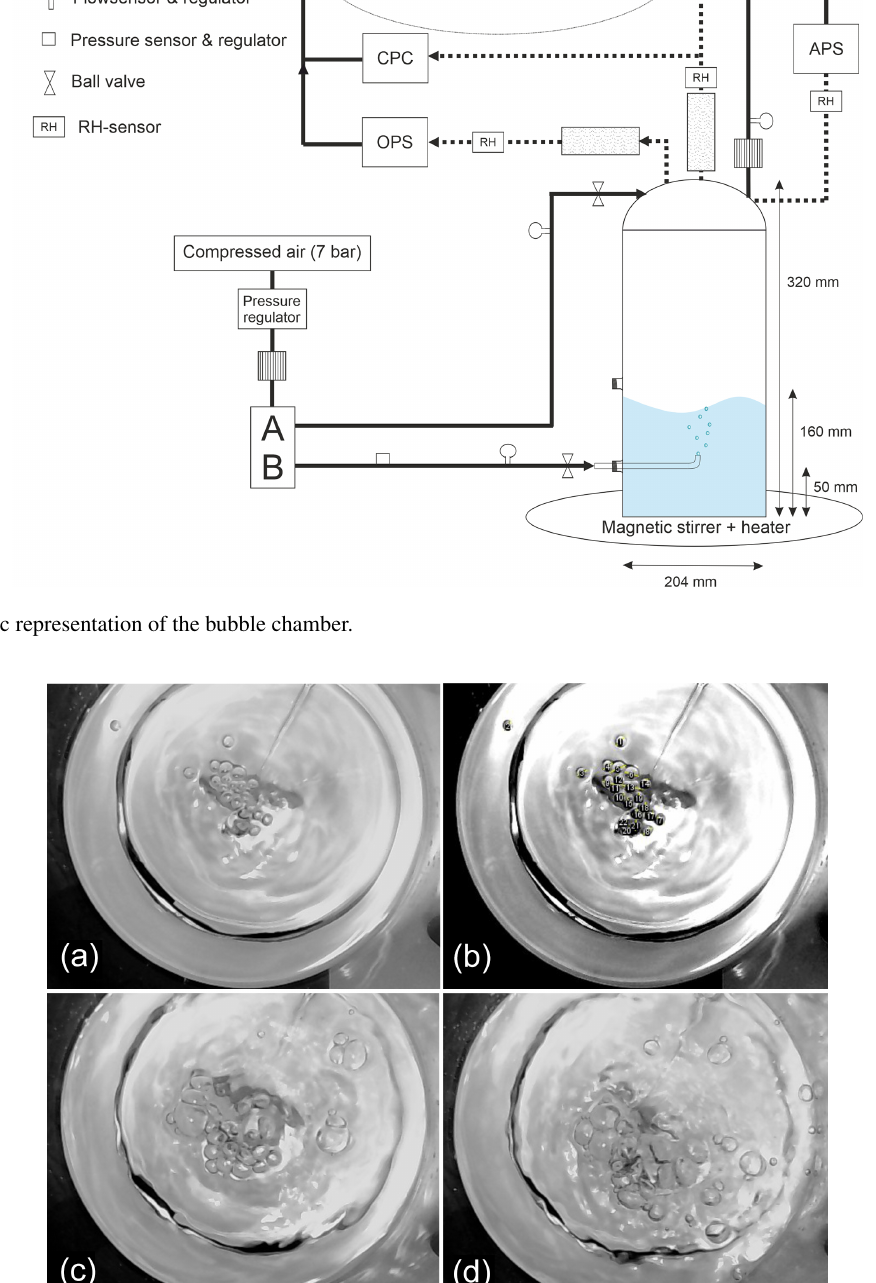
Atmos. Meas. Tech., 15, 6201–6219, 2022